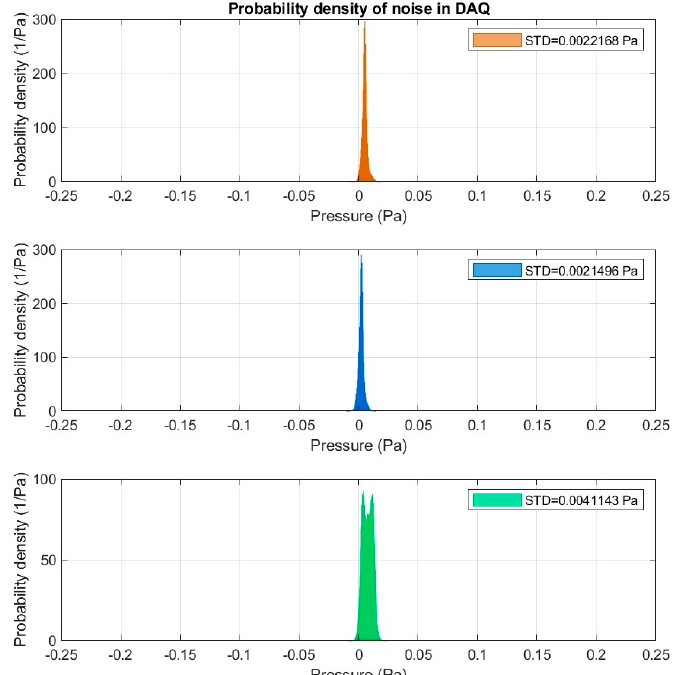
Figure 2. Probability density of noise in data acquisition system (DAQ): Orange color—measuring setup number 1; blue color—measuring setup number 2 and green color—measuring setup number 3.